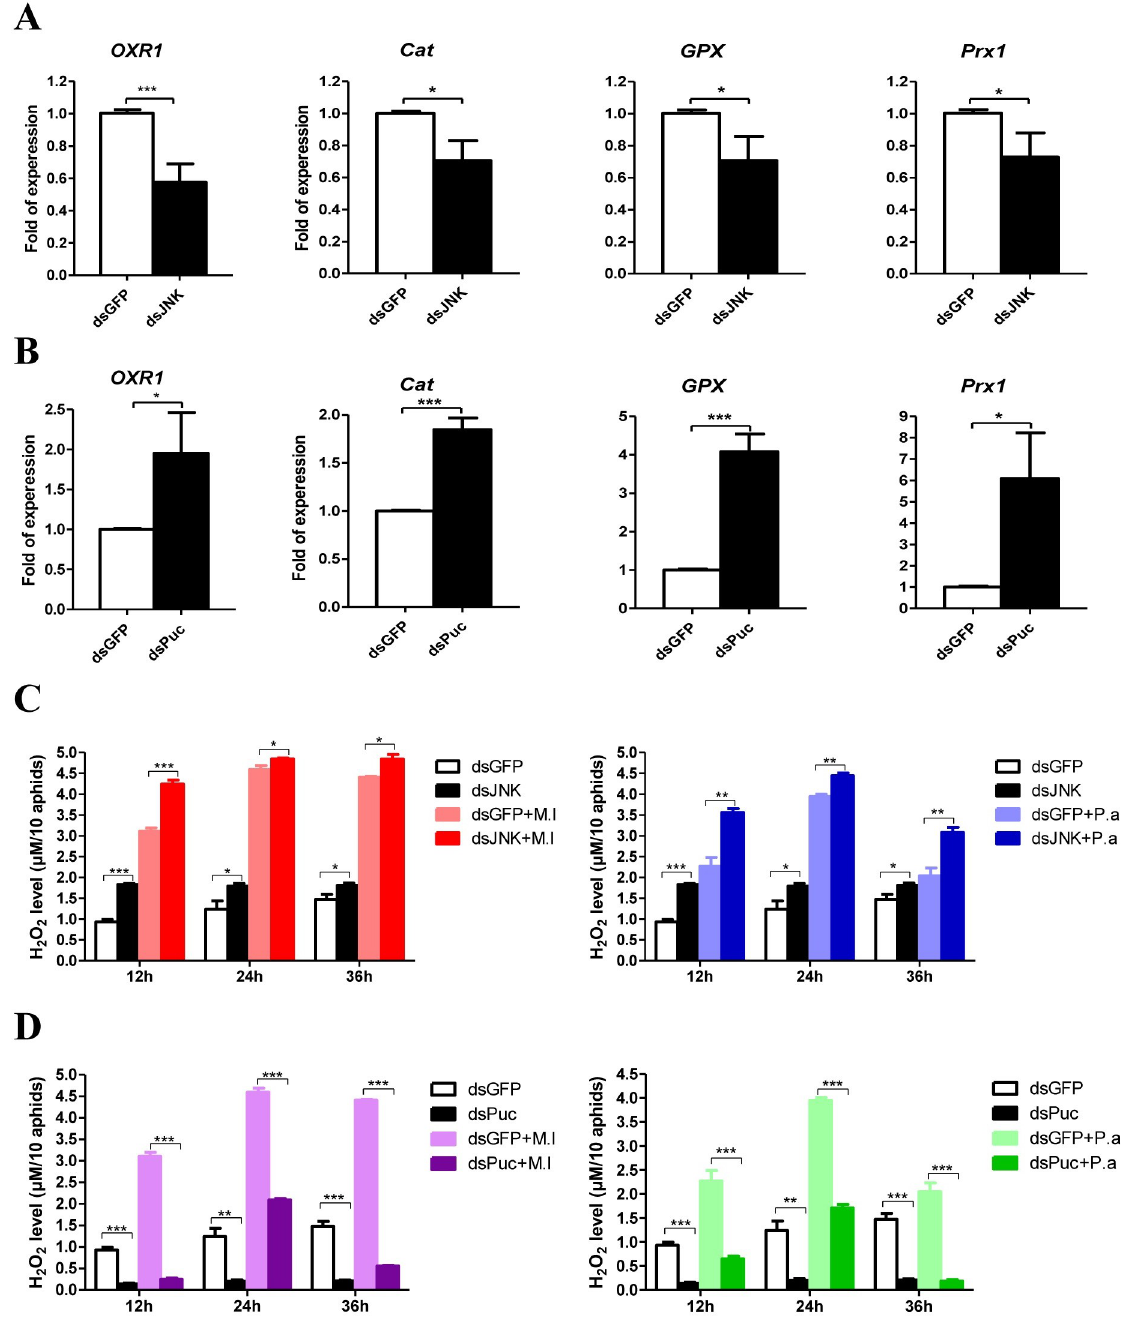
Fig 2. JNK pathway regulates ROS metabolism. Effect of JNK (A) and Puc (B) silence on the expression of antioxidant genes: OXR1 , Cat , GPX and Prx1 of the pea aphids. The expressions of OXR1 , Cat , GPX and Prx1 were normalized with rpl7 of the pea aphids. The statistical differences between the dsGFP injected groups and dsJNK or dsPuc injected groups were denoted with asterisks. Effect of JNK (C) and Puc (D) silence on the H 2 O 2 concentration in the aphids uninfected and infected by M . luteus (M.l) and P . aeruginosa (P.a). Ten aphids from each group at each time point were used for the measurements of H 2 O 2 concentration. The statistical differences between the compared groups were denoted with asterisks. For (A-D) , the values shown are the mean ( ± SEM) of three independent experiments. P values were determined by Student’s t test. � P < 0.05; �� P < 0.01; ��� P < 0.001.